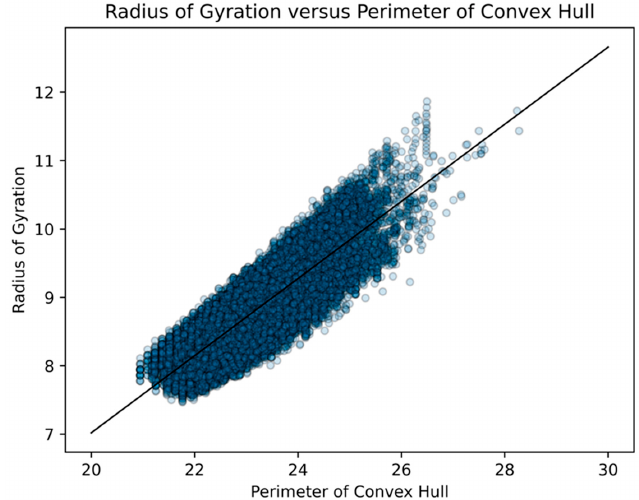
Figure 22. For all 43,380 Dürer nets of dodecahedra, we did a scatterplot of the perimeters of their respective convex hulls with their respective radii of gyration. We standardized the length of an edge of a pentagonal face of a dodecahedron at “1”. The R2 value was 0.738 and the probability of being due to randomness was less than 10 − 6 . This significant linear relationship held for all nets with vertex connections ranging from 2 to 10.